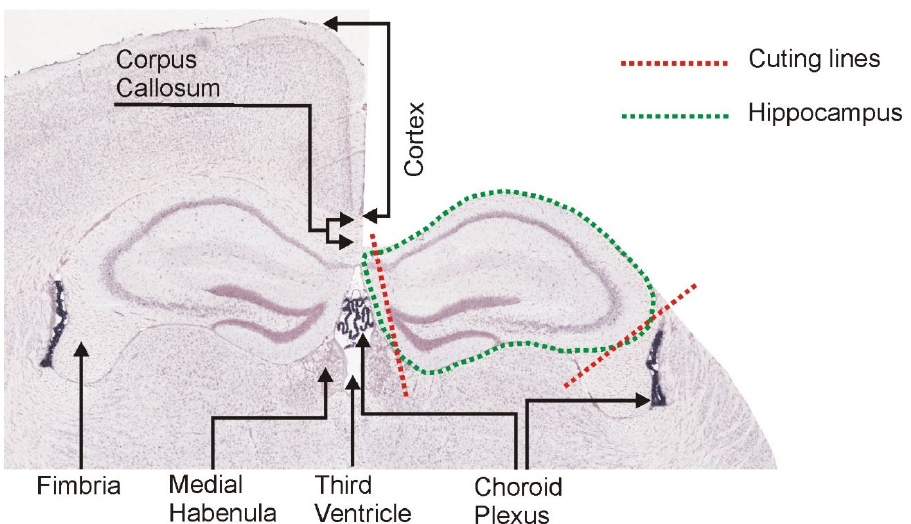
Figure 4. Coronal section of the mouse brain showing spatial relationship between dorsal hippocampus and choroid plexus. The in situ hybridization (ISH) image was derived from the Allen Mouse Brain Atlas (https://mouse.brain-map.org/, accessed on 4 January 2022) [13]. Part of the cortex (right side of the image) has been masked to visualize brain during the dissection process (Figure 3, Supplementary Figure S1 and Supplementary Video S2 File). Table 1. Primers used for PCR validation of dissection